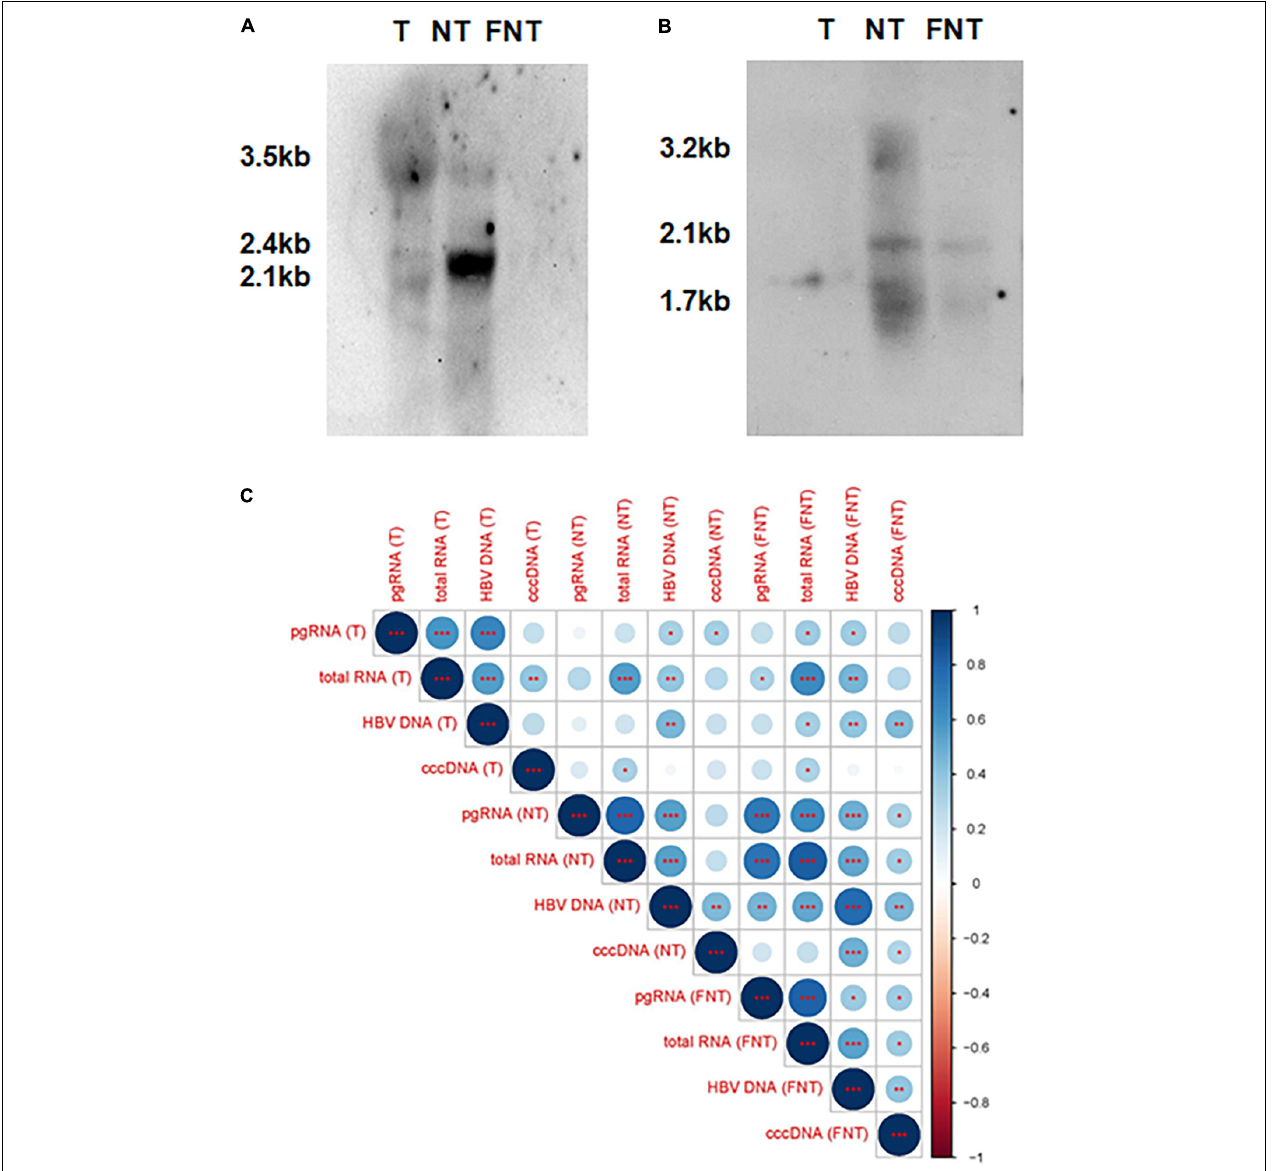
FIGURE 2 | Comparisons and correlations of HBV markers among T, NT, and FNT compartments. (A) Northern blot of HBV RNAs marker. (B) Southern blot of HBV DNA markers. (C) Correlations between HBV markers (DNA, cccDNA, total RNA, and pgRNA) within each compartment and serum HBV DNA. The intersection of the column and row indicates the correlation between the two variables, the color of the circle indicates positive and negative correlation (blue for positive correlation, red for negative correlation), and the diameter of the circle indicates the size of the correlation coefficient. Statistical analysis was performed by Spearman rank correlation test ∗ p < 0.05; ∗∗ p < 0.01; ∗∗∗ p < 0.001. T, tumor; NT, adjacent non-tumor; FNT, distal